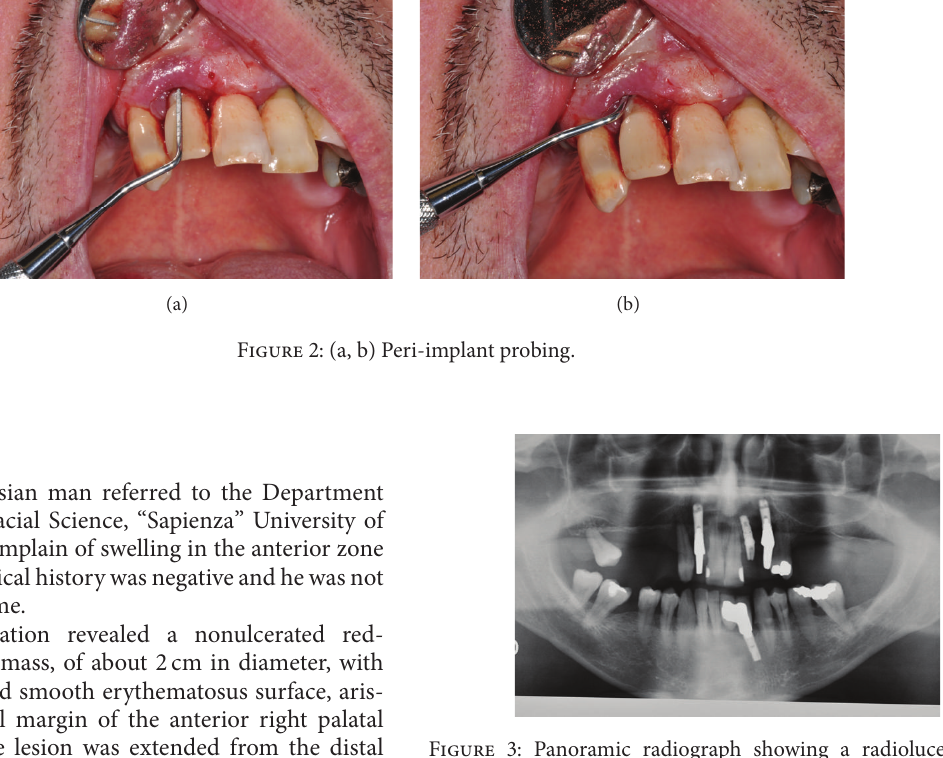
Figure 3: Panoramic radiograph showing a radiolucent lesion surrounding the implant and the upper right